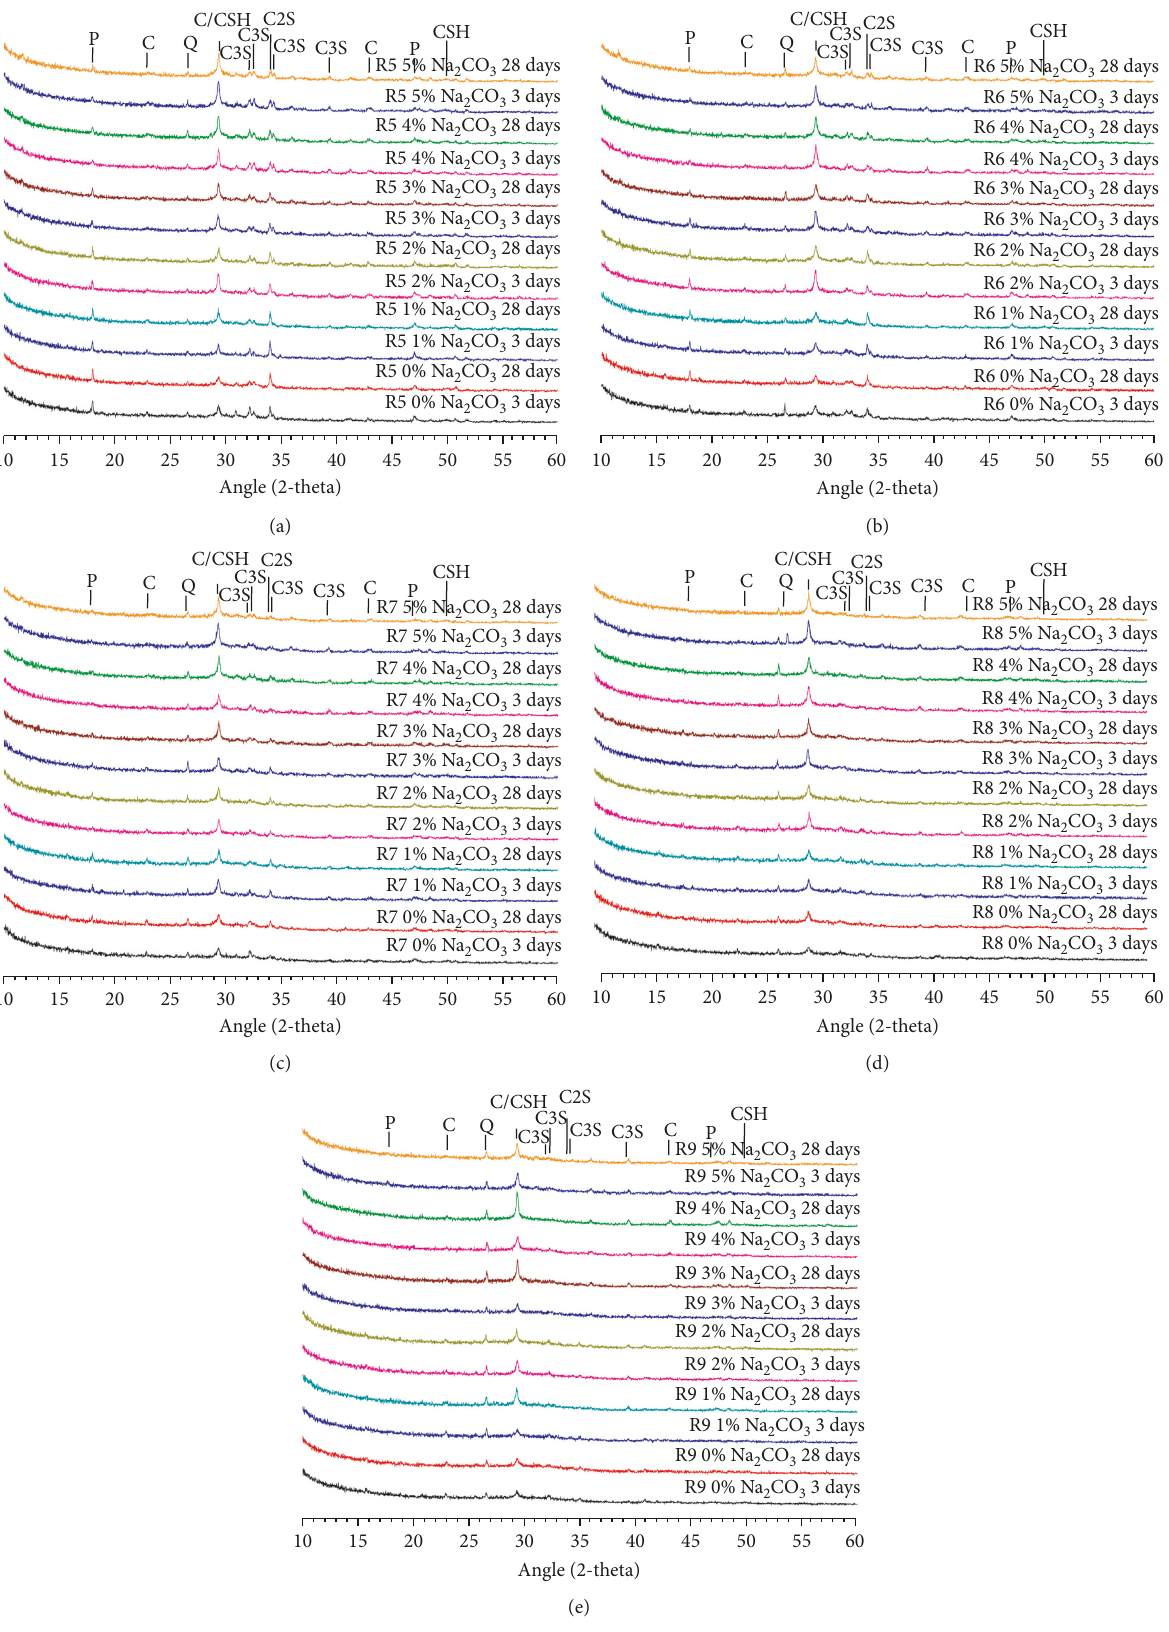
Figure 3: X-ray diffraction spectra for Na 2 CO 3 -activated HVSC pastes with different GGBFS replacement levels: (a) R5, (b) R6, (c) R7, (d) R8, and (e) R9 samples. Peak positions are indicated for portlandite (P); calcite (C); quartz (Q); C–S–H (CSH); alite (C 3 S); belite (C 2